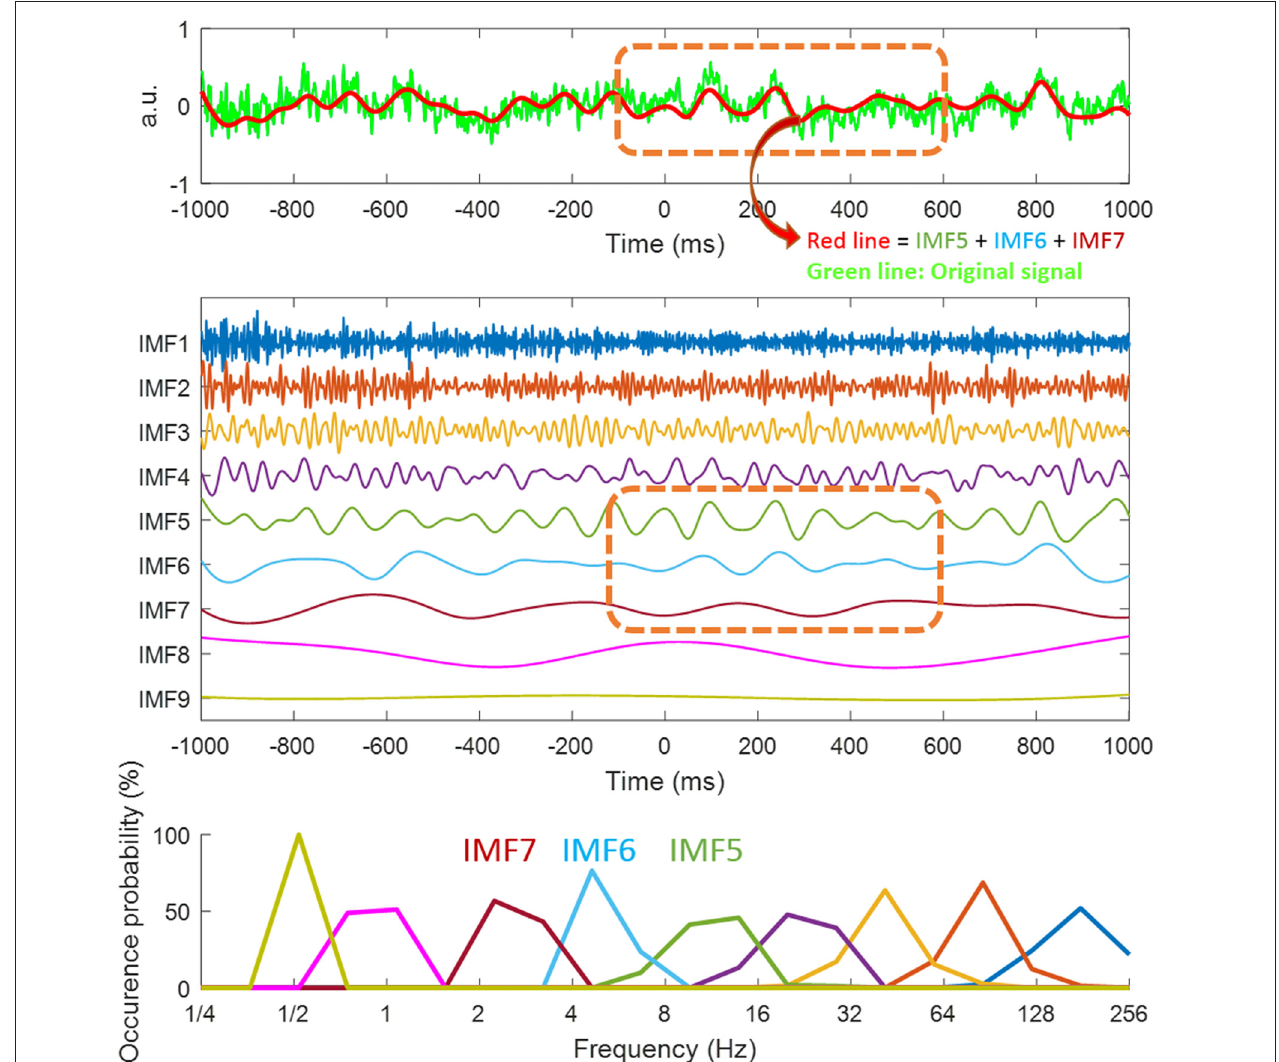
FIGURE 3 | Illustration of intrinsic mode functions (IMFs) from ensemble empirical mode decomposition (EEMD). Decomposition of the signal from the P3/P4 electrodes for target color (TC) conditions (the green line in top panel) through EEMD. We obtained nine IMFs (middle panel). For the first two graphs, the x -axis is time with 0 ms being the distractor onset. Different IMFs represented electrophysiological activities in different frequencies. For instance, IMF1 (1st IMF) was high frequency noise, IMF2 and IMF3 represented gamma activity and IMF4 was beta activity. Because the interested event-related potential (ERP) components (i.e., N2pc and Pd) in this study are all within low frequency range, we summed up IMF5, IMF6 and IMF7 (i.e., alpha, theta and delta activity) for the current event-related mode (ERM) analysis (the red line in the top graph). The last IMF (IMF 9) is the trend of the analyzed data. The orange dotted line (graphs 1 and 2) is the time window for ERM analysis. Bottom panel showed the distribution of instantaneous frequencies of each IMF.